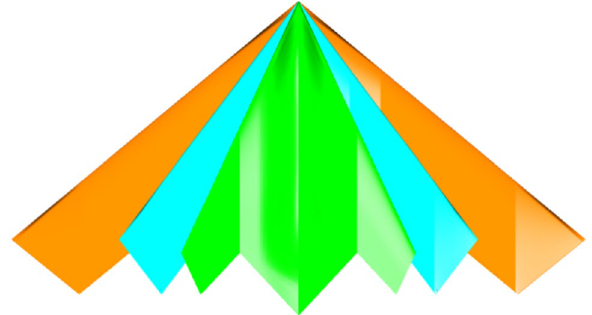
Figure 1. Flying wing configurations with different aspect